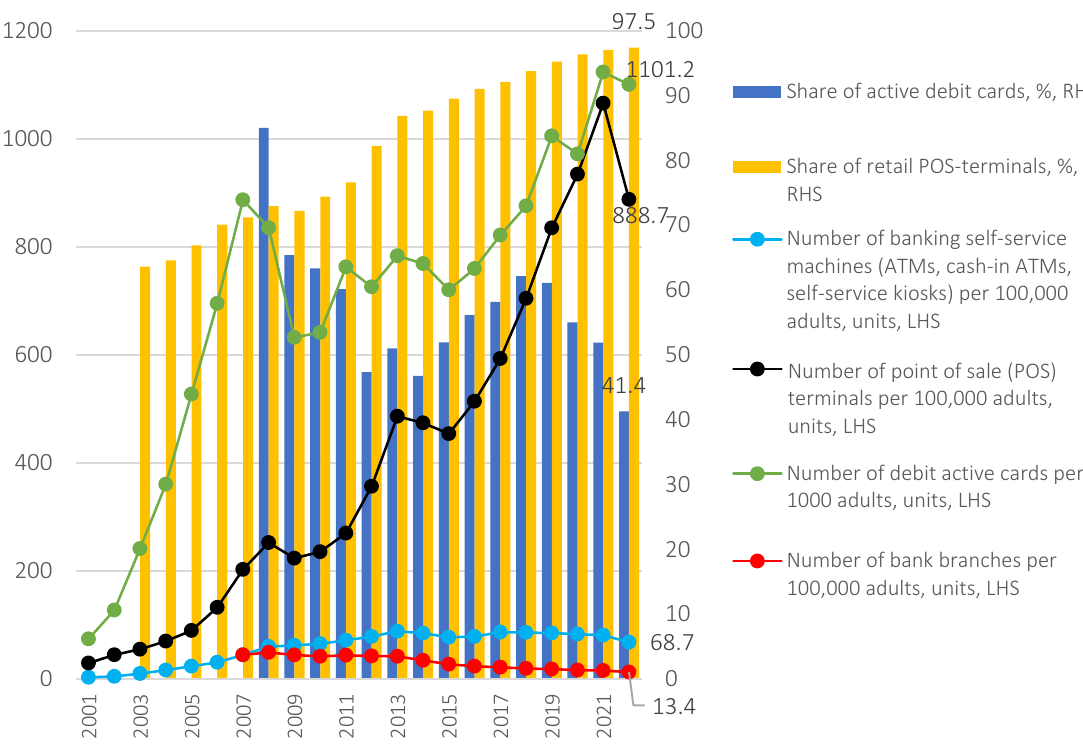
Figure 2. Ukraine’s payment infrastructure, 2001 – November